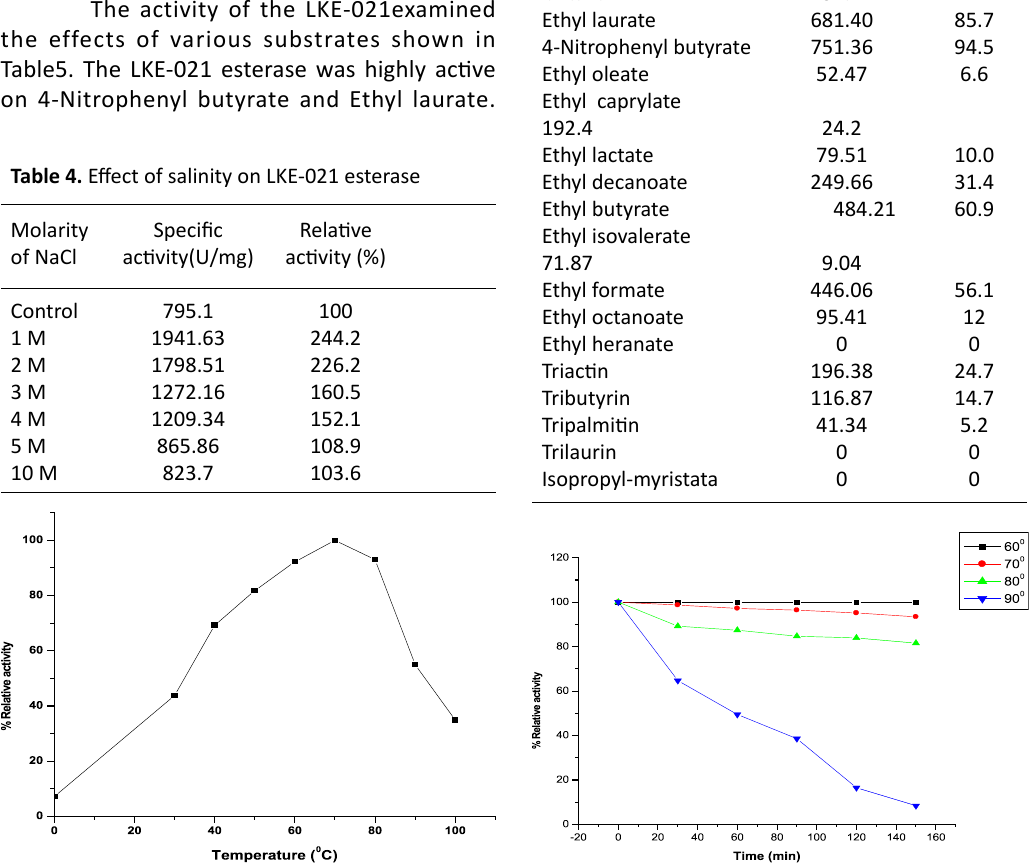
Fig. 4. Temperature effect on theactivity of LKE-021 Fig. 5. Time effecton the activity and stability of LKE- 021 Esterase